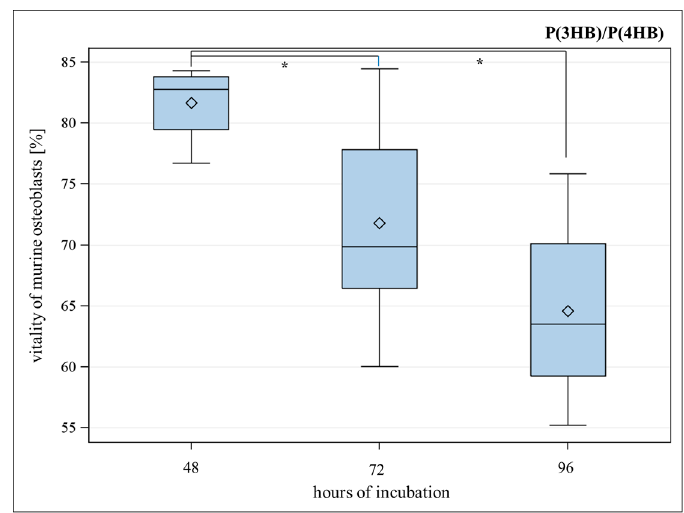
Figure 2. Vitality (%) of murine osteoblasts settled on P(3HB)/P(4HB) (poly(3-hydroxy-butyrate)/ poly(4-hydroxy-butyrate) for 48, 72 and 96 h. Global F -test from the analyses of variance followed by pairwise multiple means comparisons with the Least Significant Difference test showed a significant difference between the vitality after 48 and 72 h meanwhile between 48 and 96 h (* = p ≤ 0.05, n = 8; circle = outlier; rhombus = mean; centered line = median).